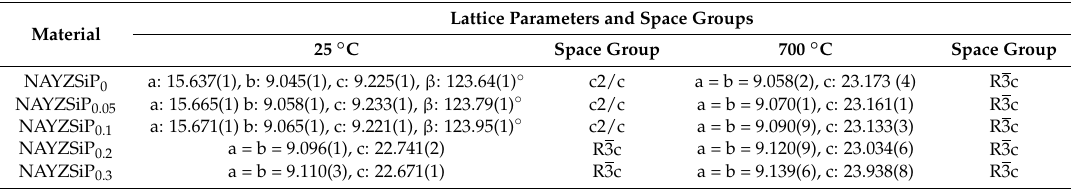
Table 1. Composition and crystal structure of NAYZSiP x